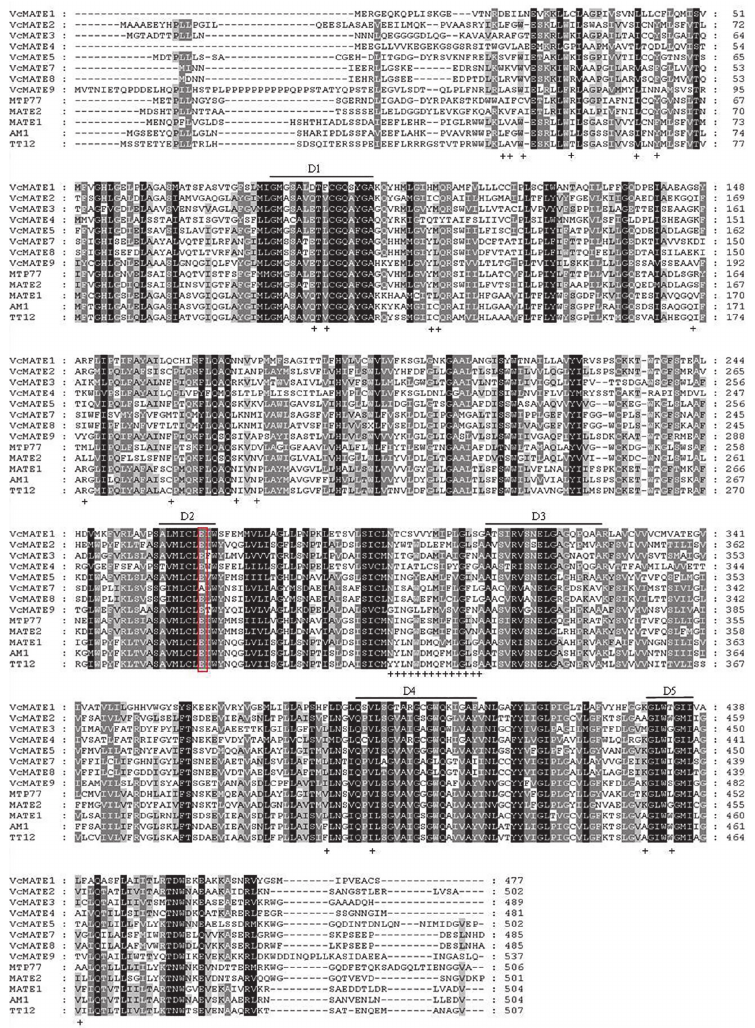
Fig 3. Multiple sequence alignment of deduced amino acid sequences of VcMATEs with selected MATE transporter orthologs. Protein sequence alignment was performed using Clustalx. Formatting of aligned sequences was accomplished with the box shade program. Amino acids that are identical in all 8 proteins are highlighted in black and conservative substitutions are highlighted in gray. Alignment of all 56 Arabidopsis MATE proteins resulted in five short stretches containing conserved amino acids, which are highlighted by thin lines above the alignment and noted as D1 – 5. The residue E290 (TT12), constituting the cation-binding site in the pore, is highlighted by a red